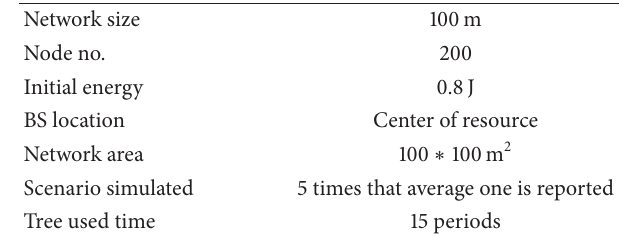
Table 7: Simulation parameters.